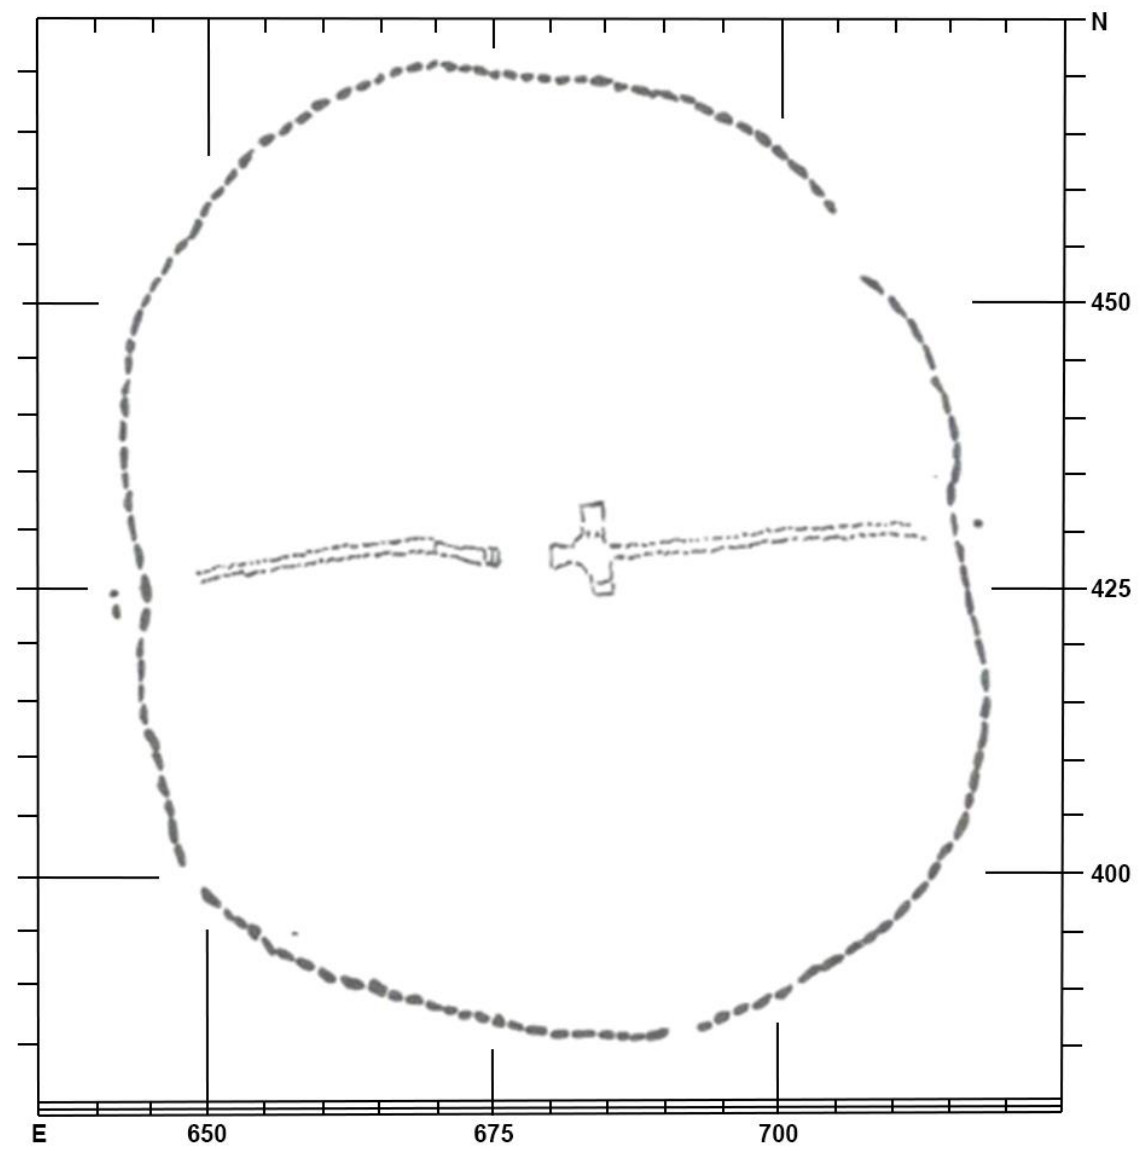
Figure 1. Plan of Knowth showing the two passages and the standing stones outside their entrances. The kerbstone positions are located after Eogan (1986: 31) but the map has been reset on the Irish Ordnance Survey grid, while noting that true north is 1 degree 13’ west of grid north (see also Prendergast & Ray 2015). Each northing is to be preceded by 273, thus N 273400, and each easting by 299, thus E 299700). The eastern passage is 40.4m long (Figure 2), and the western passage is 34.2m